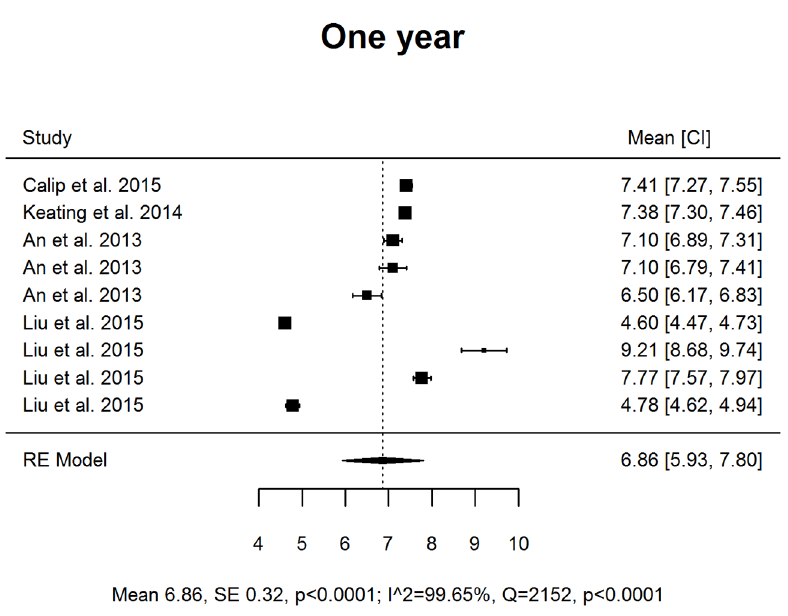
Fig 3. Forest plot of studies considering mean HbA1c levels (%) at 12 months post time of cancer diagnosis and treatment initiation.